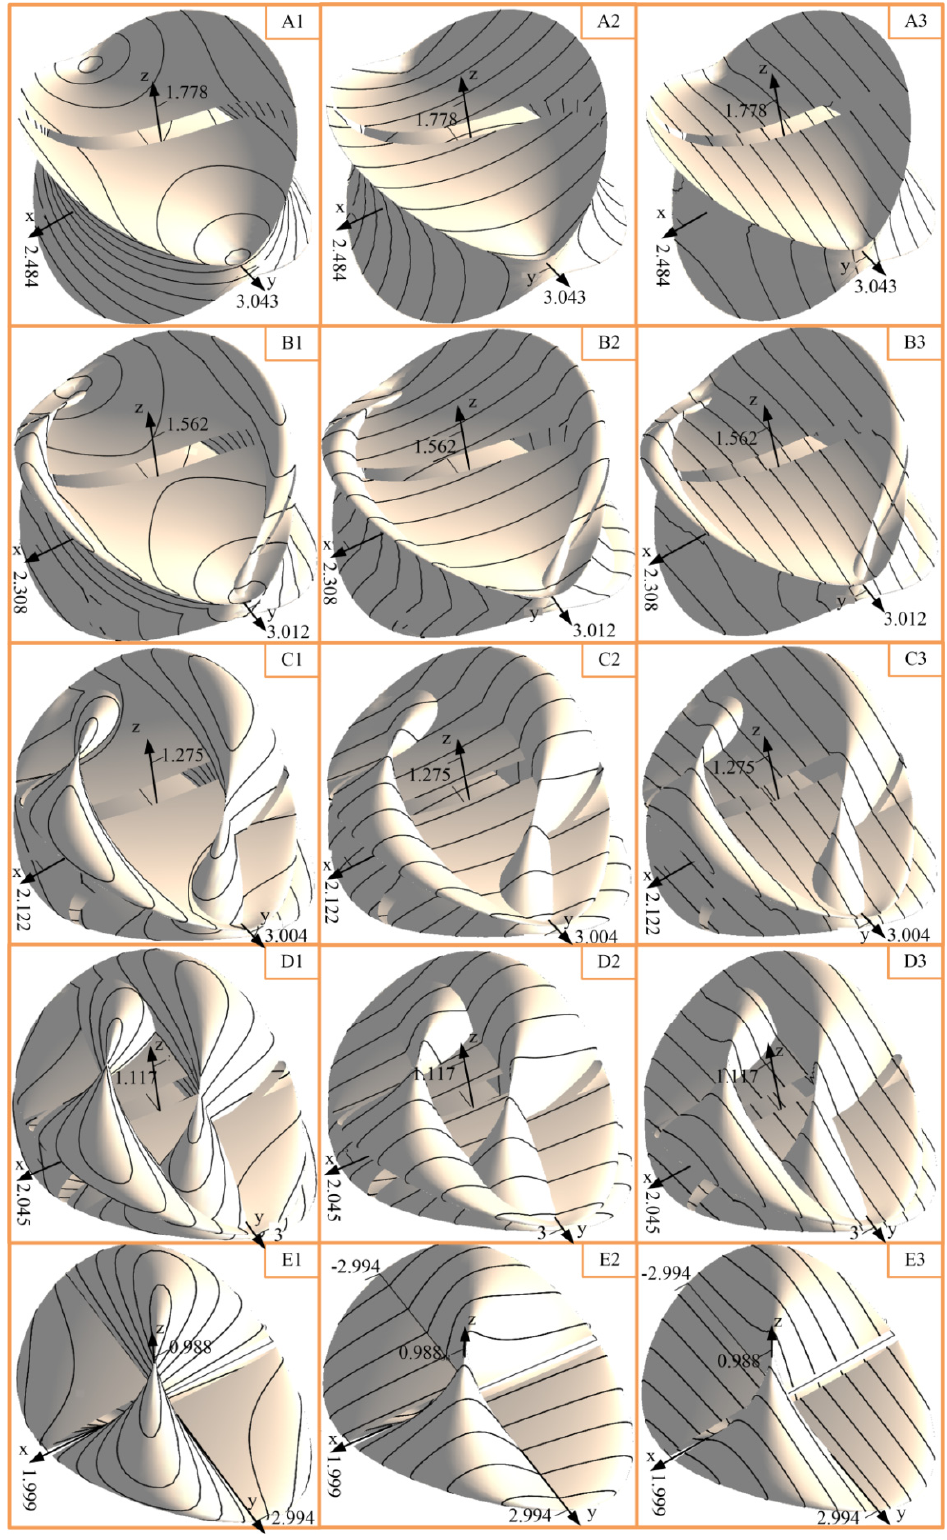
⊥ S to the boundary surface. Figure 5. The evolutionary process of the surface S ⊥ to the boundary